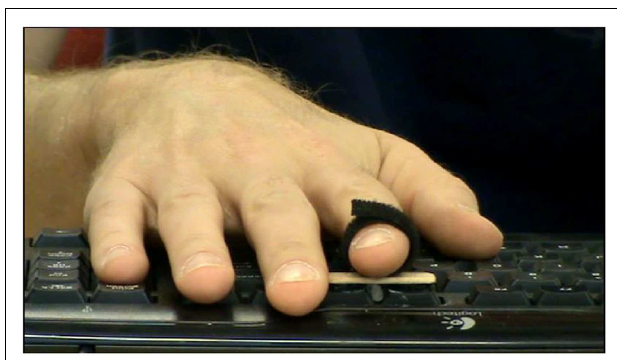
FIGURE 1 |A video still showing an example stimulus used in the experiment. The same set of videos was used in all four conditions (intentional causal, intentional non-causal, unintentional causal, unintentional non-causal). In the causal conditions the key press made in the video caused a tone effect after a delay of 100, 400, or 700ms.The only difference in the two causal conditions was the description of the movement and, consequently, the belief of the observer regarding its intentionality. In these causal conditions participants estimated the duration of this interval in milliseconds. In the non-causal conditions the key press did not cause a tone effect. Again, the only difference in the non-causal conditions was the description of the movement (intentional or unintentional). In these non-causal conditions the participants had to press a response key as soon as possible after they detected an asterisk appearing at a random location on the video over the model’s hand (on 20% of